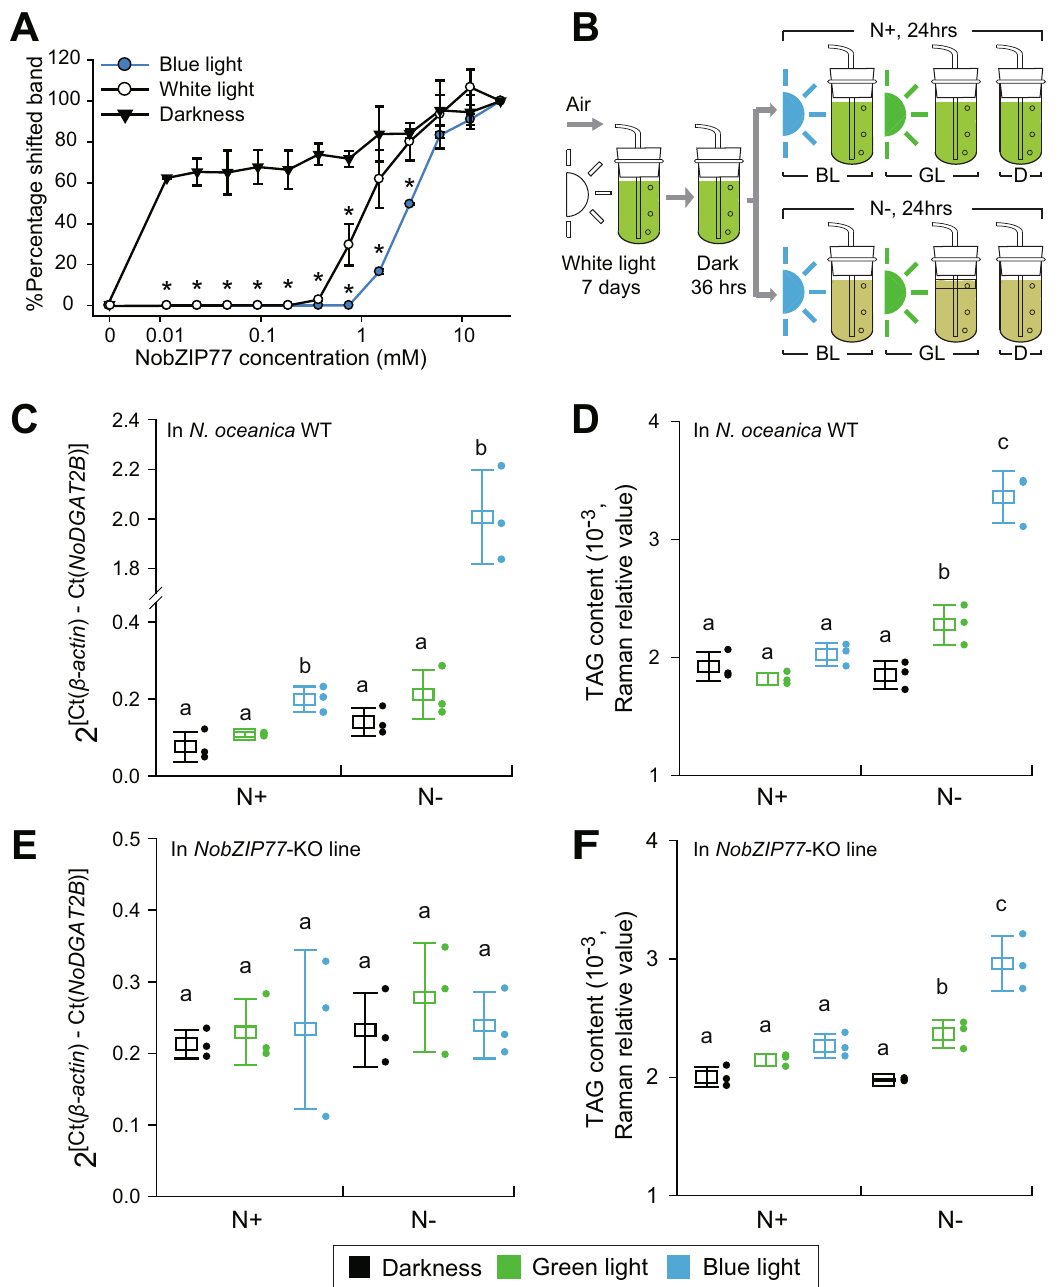
Fig. 3 Blue light reduces the binding of NobZIP77 to the NoDGAT2B promoter. A DNA-binding curves of NobZIP77 under the dark, white light (WL) or blue light (BL). The curves were generated by quantifying the relative amount of shifted bands of NobZIP77 bound to p NoDGAT2B in EMSA. The samples derive from the same experiment and that gels/blots were processed in parallel. Data are represented as mean ± SD ( n = 2 biologically independent samples). *: signi fi cant change ( p ≤ 0.05) by one-sided Student ’ s t -test versus darkness. B Experimental design that probes the speci fi city of BL to the NobZIP77-mediated NoDGAT2B expression and TAG synthesis in vivo, under N + or N − . BL, blue light; GL, green light; D, darkness. C , E Transcript level of NoDGAT2B in WT ( C ) and in the knockout mutant of NobZIP77ko-1 ( E ). D , F TAG content of WT ( D ) and NobZIP77ko-1 ( F ). Data are represented as mean ± SD ( n = 3 biologically independent samples). Letters above the bars indicate signi fi cant difference ( p ≤ 0.05), based on one-way analysis of variance (ANOVA) and Tukey ’ s honestly signi fi cant difference (HSD) test. Source data are provided as a Source data fi